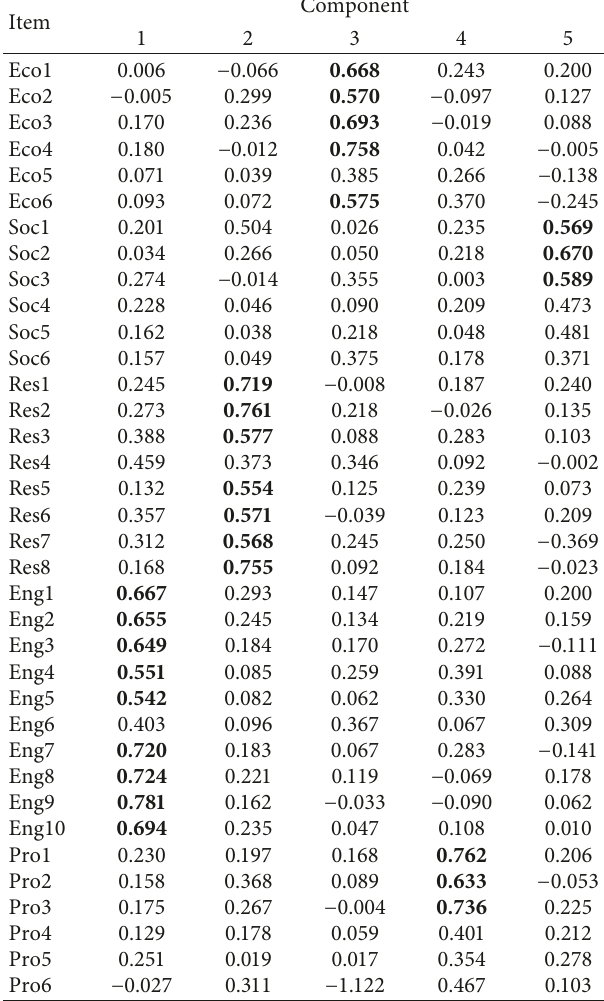
Table 3: Test values of KMO and Bartlett. Table 4: Measures of the rotated component matrix.